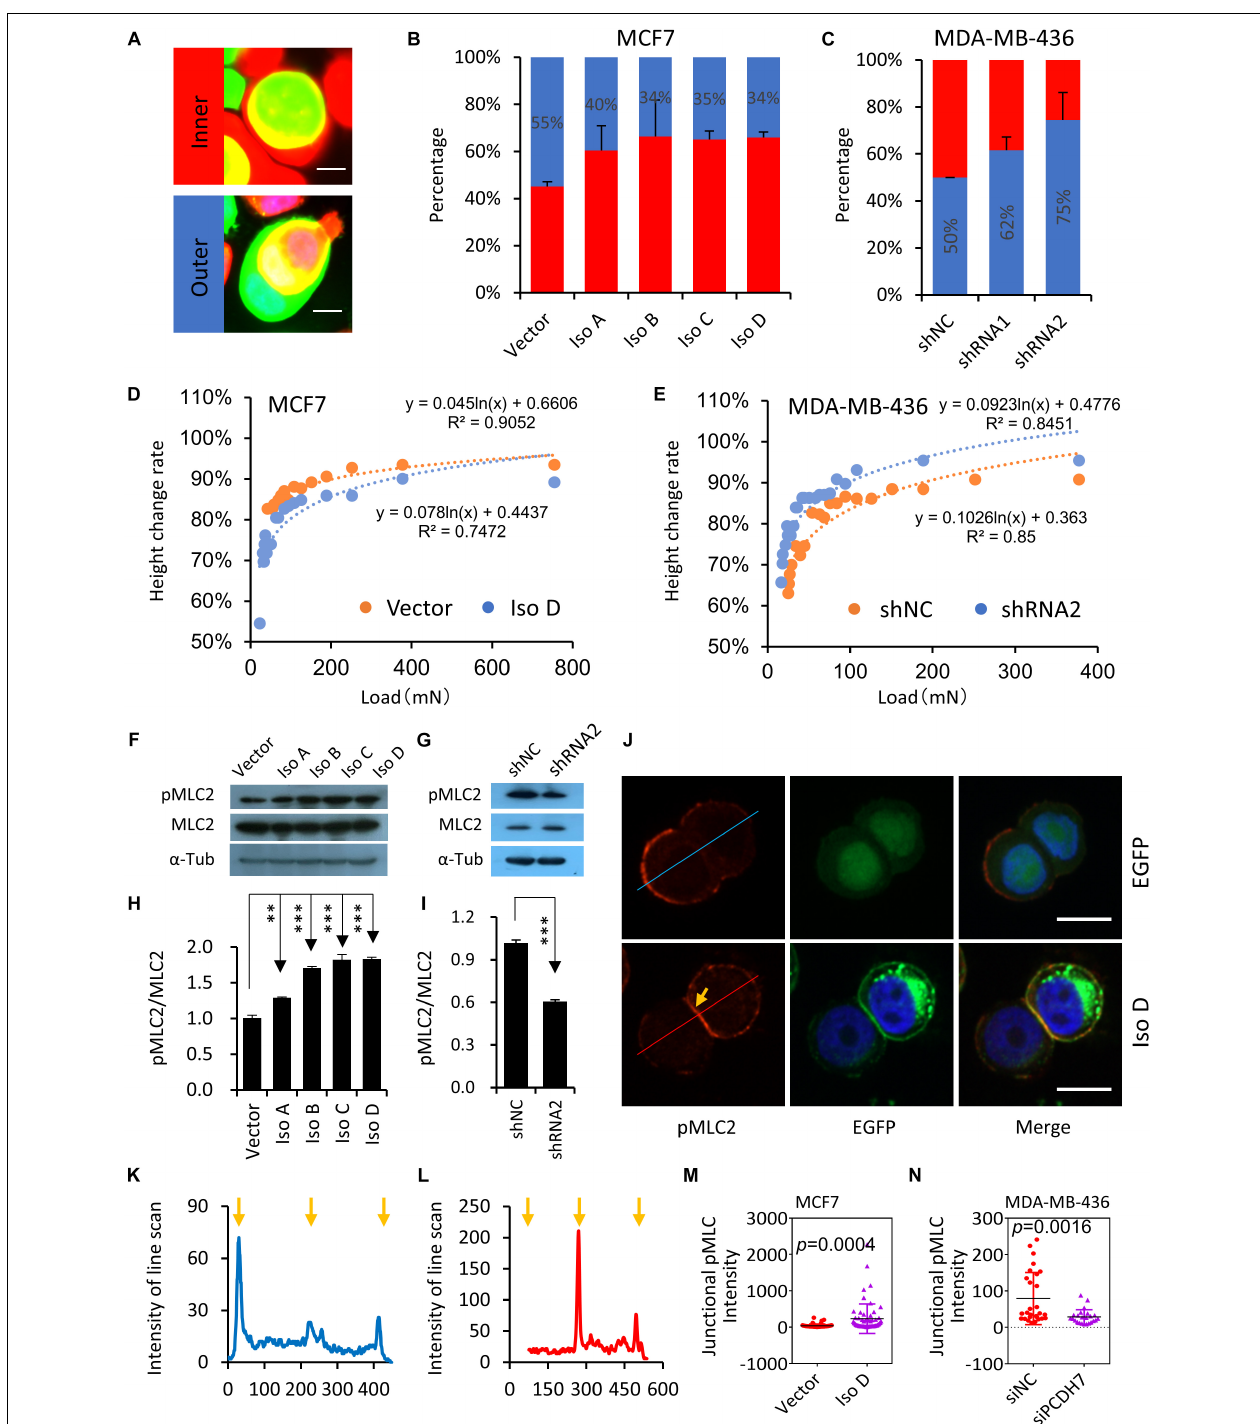
FIGURE 3 | PCDH7 enhances actomyosin contraction and cell stiffness. (A) Images depicting the relative identities of EGFP-expressing cells. Scale bar: 10 µ m (B) PCDH7 overexpression (EGFP +) promotes cells internalization as inner cell. n > 60 CIC structures each. Data are mean ± SD of triplicate experiments. P < 0.05 for isoforms compared with control. (C) PCDH7 depletion (EGFP +) confers cells the identity of outer cell. n > 60 CIC structures each. Data are mean ± SD of triplicate experiments. P < 0.05 for two hairpins compared with control. (D,E) Deformation of cells with PCDH7 overexpression (D) or depletion (E) as determined by compression assay. (F,G) Expression of pMLC2 and MLC2 upon PCDH7 overexpression (F) or depletion (G) . (H,I) Quantification of the ratio of pMLC2/MLC2 in (F) or (G) , respectively. ∗∗ P < 0.01; ∗∗∗ P < 0.001. (J) Representative images for pMLC2 staining (red) in MCF7 cells. Arrow indicates junctional pMLC2. Scale bar: 15 µ m. (K,L) Relative intensity of pMLC2 by line scan analysis. (K) and (L) are corresponding to upper (EGFP) and lower (Iso D) panels, respectively. Arrows indicate cell boundaries. (M,N) Quantification of junctional pMLC2 intensity upon PCDH7 overexpression (M) or depletion (N) . n = 24 ∼ 60 junctional sites.